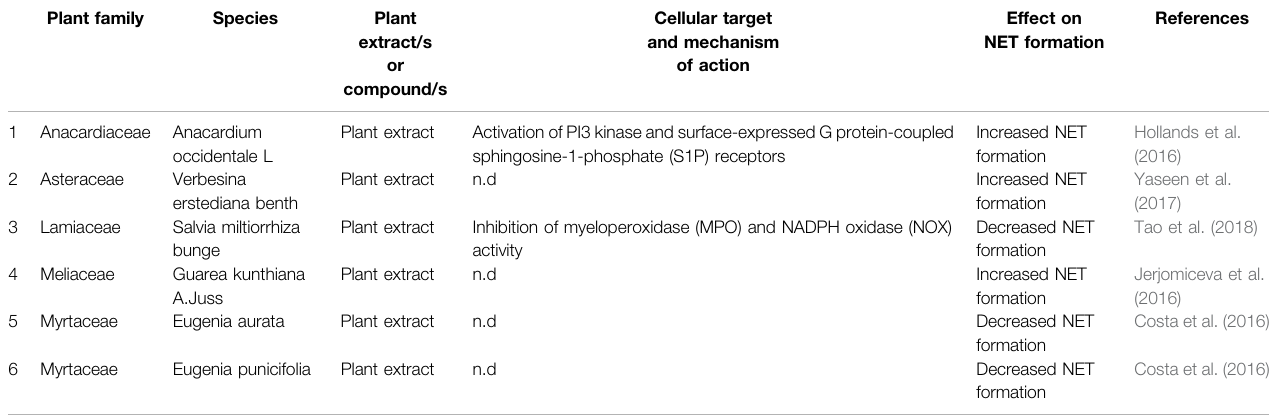
TABLE 7 | List of selected plant material with documented impact on NET formation. Plant family